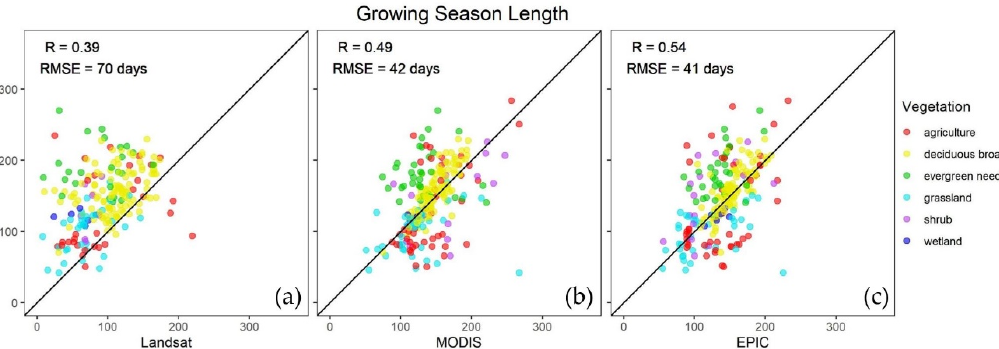
Figure 8. The correlation between EPIC and PhenoCam ( a ) SOS and ( b ) EOS DOY over 2016–2018.